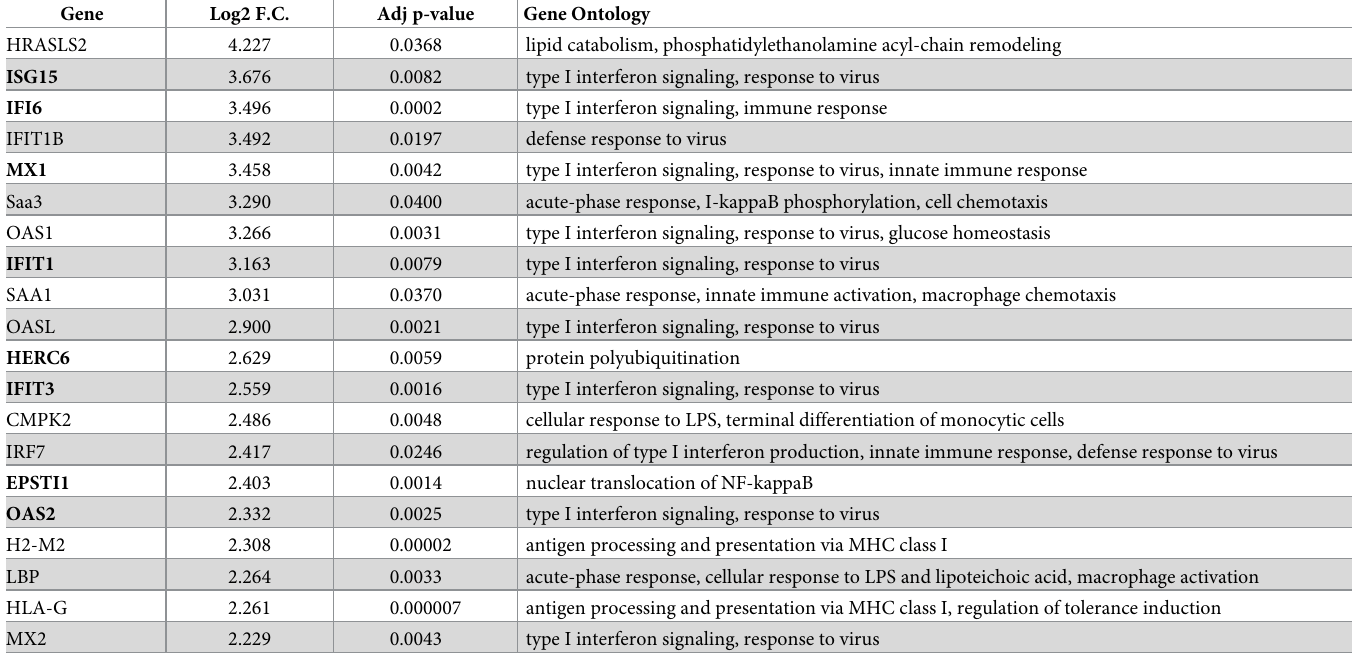
Table 2. Top differentially expressed genes in SIV+ infant macaques. Gene Log2